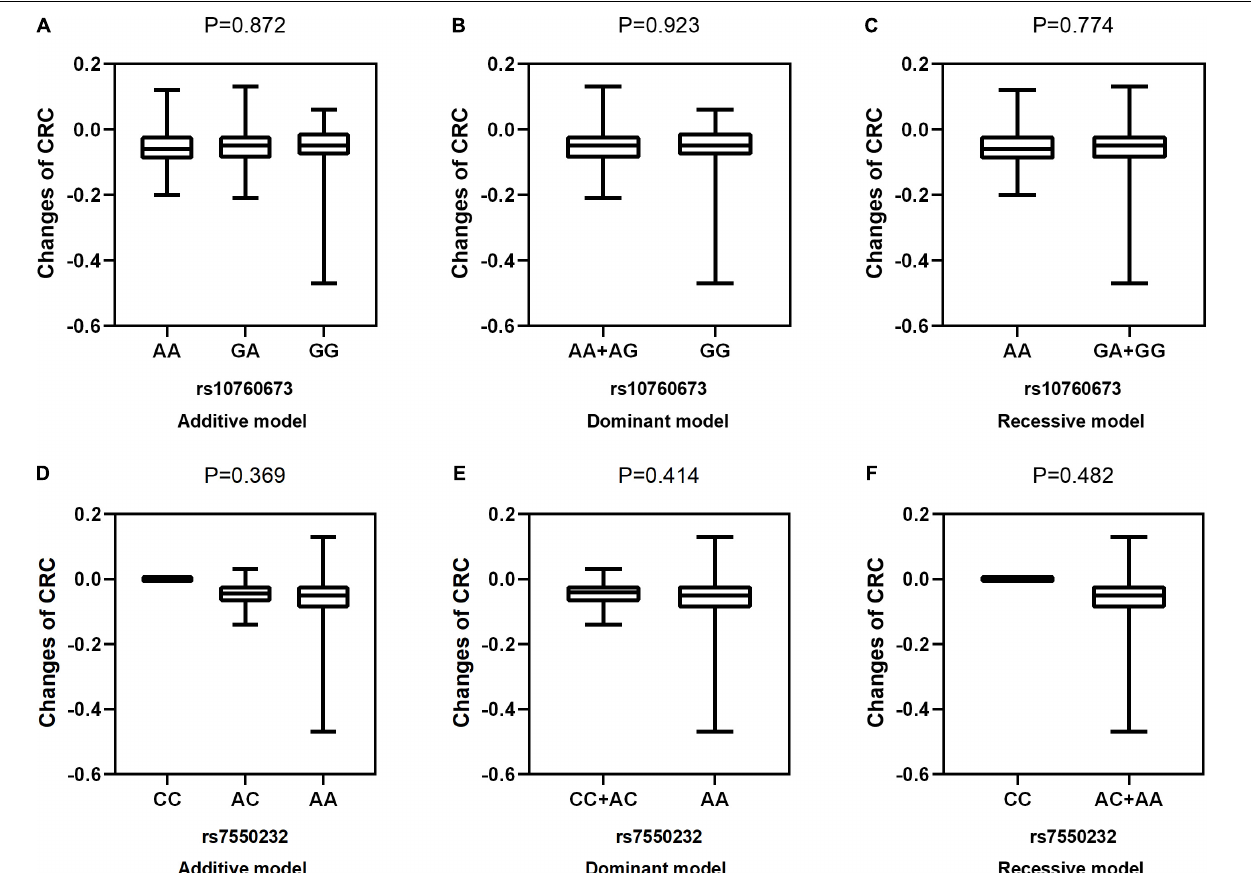
FIGURE 4 | Correlations between the two SNPs and the changes in CRC. rs10760673 [ (A) additive model, p = 0.872; (B) dominant model, p = 0.923; (C) recessive model, p = 0.774]; rs7550232 [ (D) additive model, p = 0.369; (E) dominant model, p = 0.414; (F) recessive model, p =